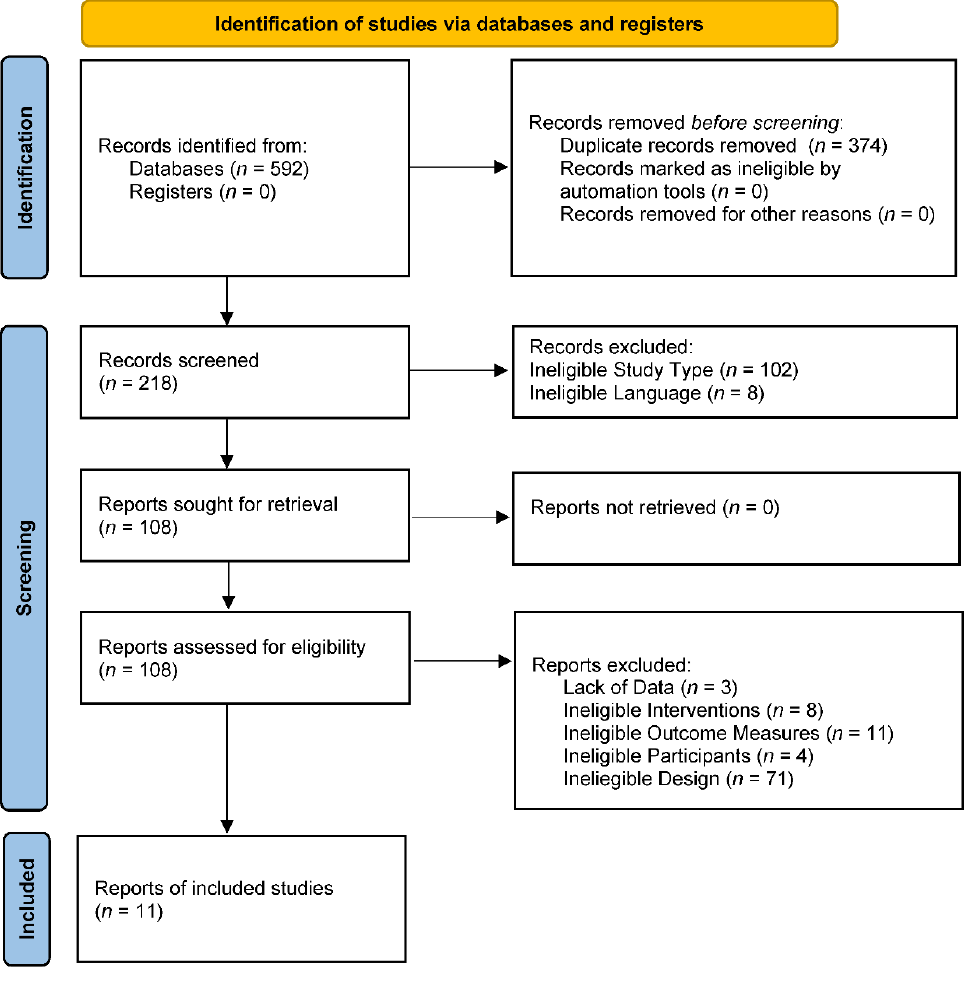
Figure 1. The PRISMA 2009 flow diagram of search and study selection.